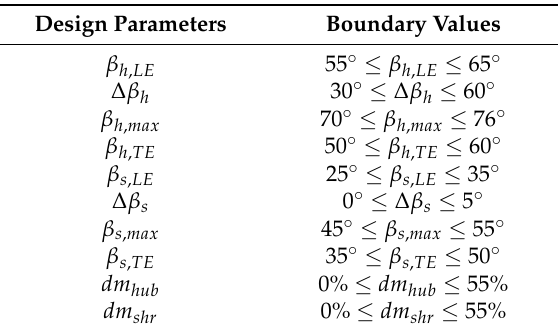
Table 2. Bounded values of design